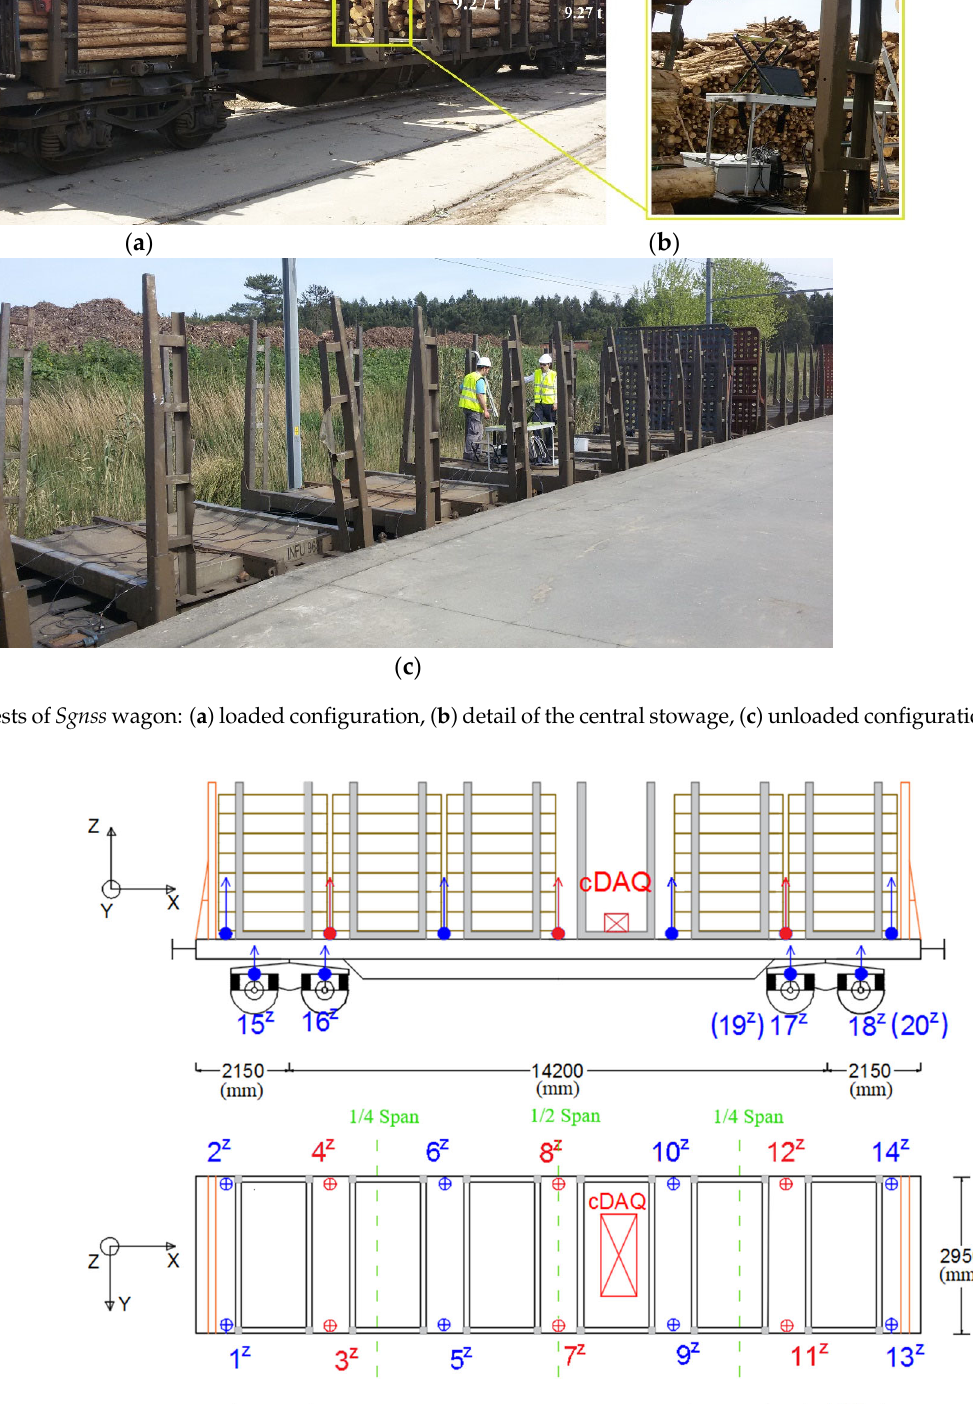
Figure 7. Dynamic tests of Sgnss wagon: DAQ and accelerometers on the platform and bogies. 3.4. Modal Identification The identification of the modal parameters for the unloaded and loaded vehicle, par ‐ ticularly the natural frequencies, mode shapes and damping coefficients, was performed by the application of the enhanced frequency domain decomposition (EFDD) method im ‐ plemented in the ARTeMIS software [48], which is a well ‐ established and robust technol ‐ ogy capable of providing accurate results even in the presence of noise on the measured